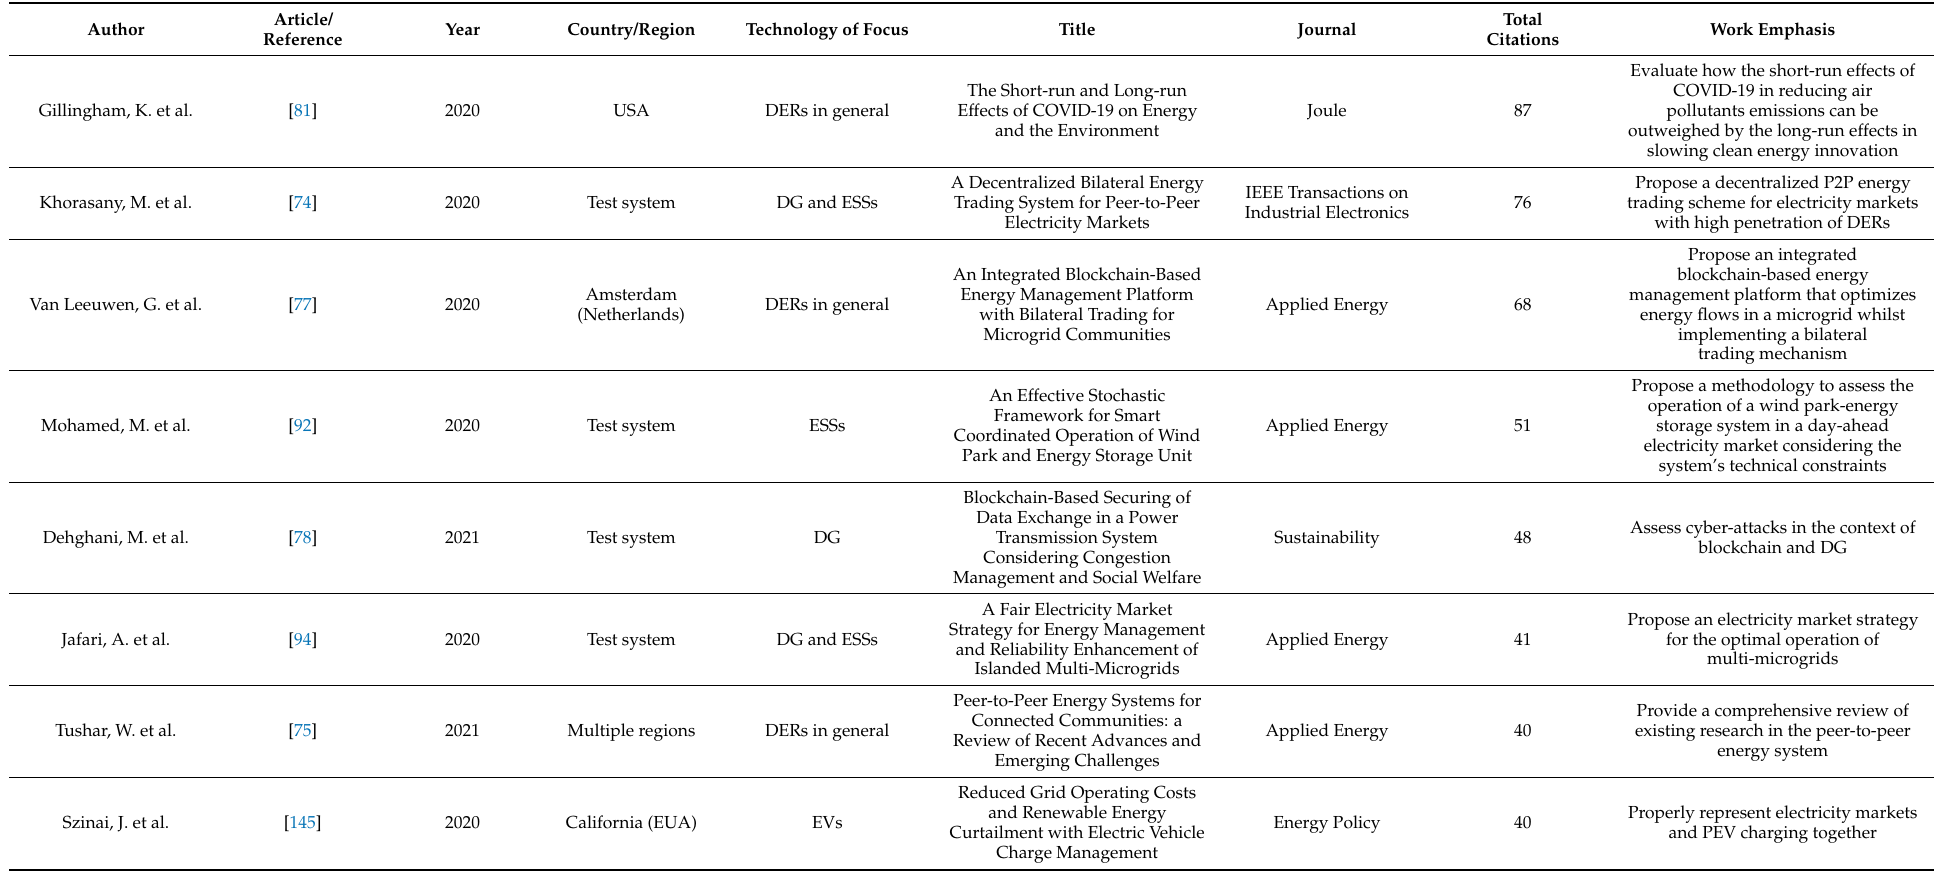
Table A3. Most-cited state-of-the-art articles from Sample 1. Source: own study using data from